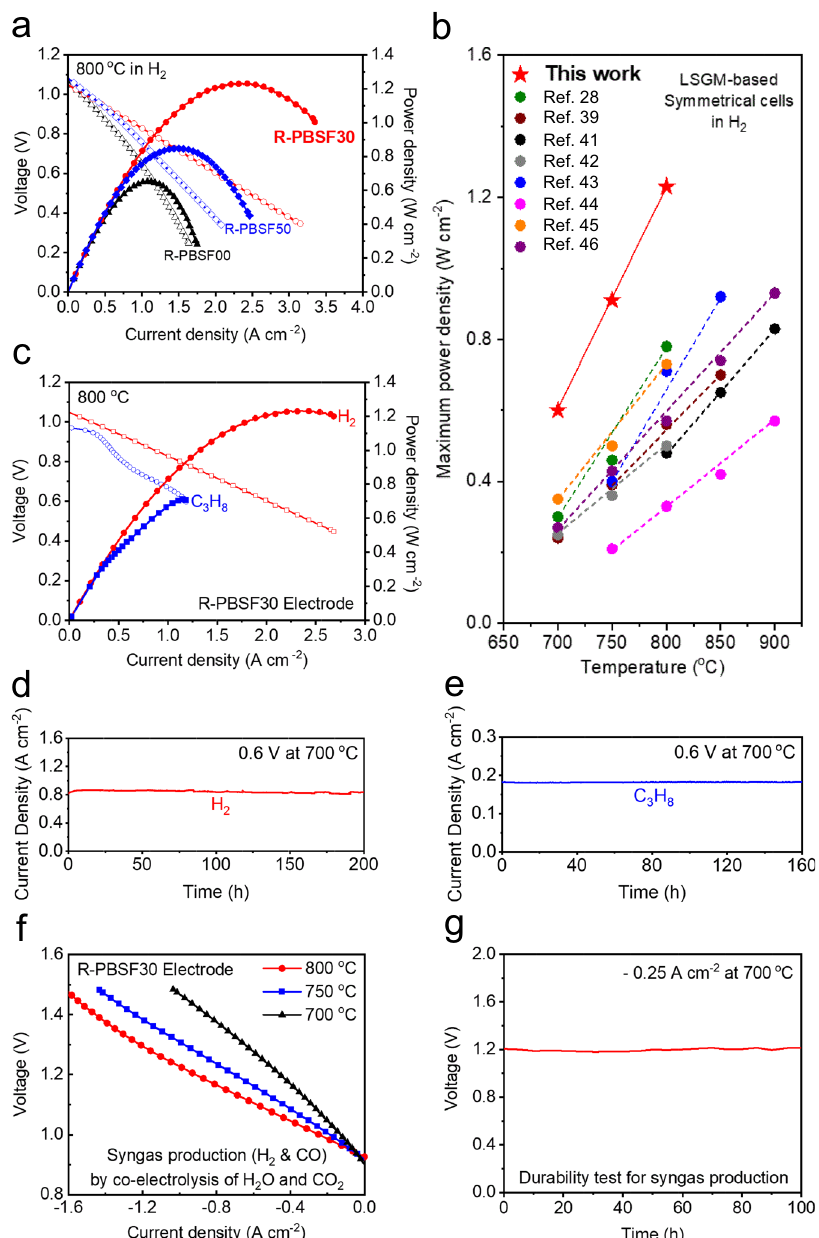
Fig. 5 Electrochemical performance measurements. a , b Comparison of the maximum power density values at 800 °C in H 2 . ( a ) in terms of Pr 0.5 Ba 0.5 − x Sr x FeO 3 − δ compositions ( x = 0, 0.3, and 0.5) and b of the present work and other LSGM electrolyte-supported studies with symmetrical